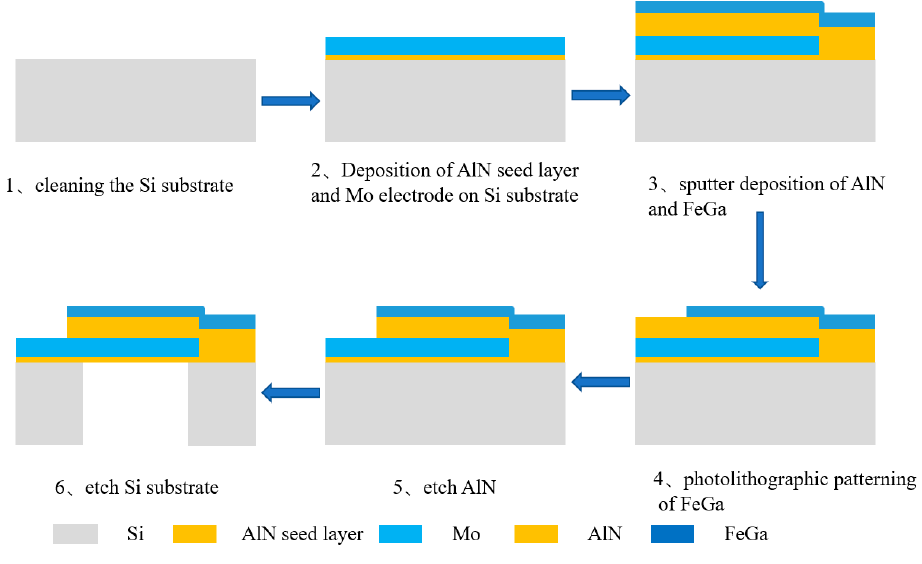
Figure 12. ME antenna preparation process. The optical image of the ME antenna is shown in Figure 13.